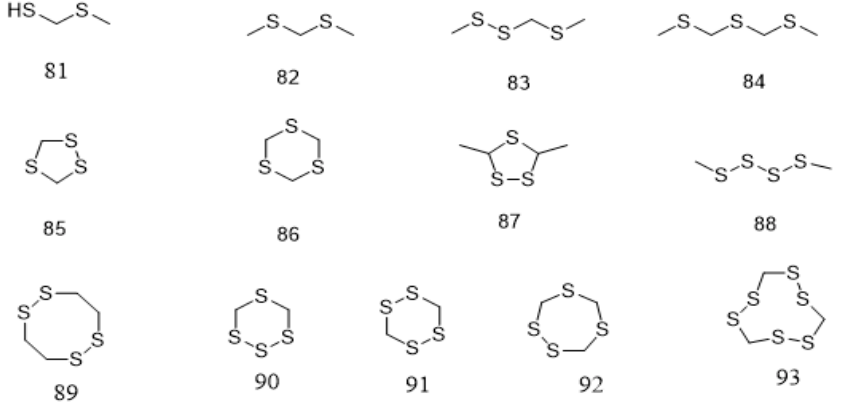
Figure 5. Structural formulas of cyclic polysulfides 81 – 93 , as previously listed in Table 2. 100